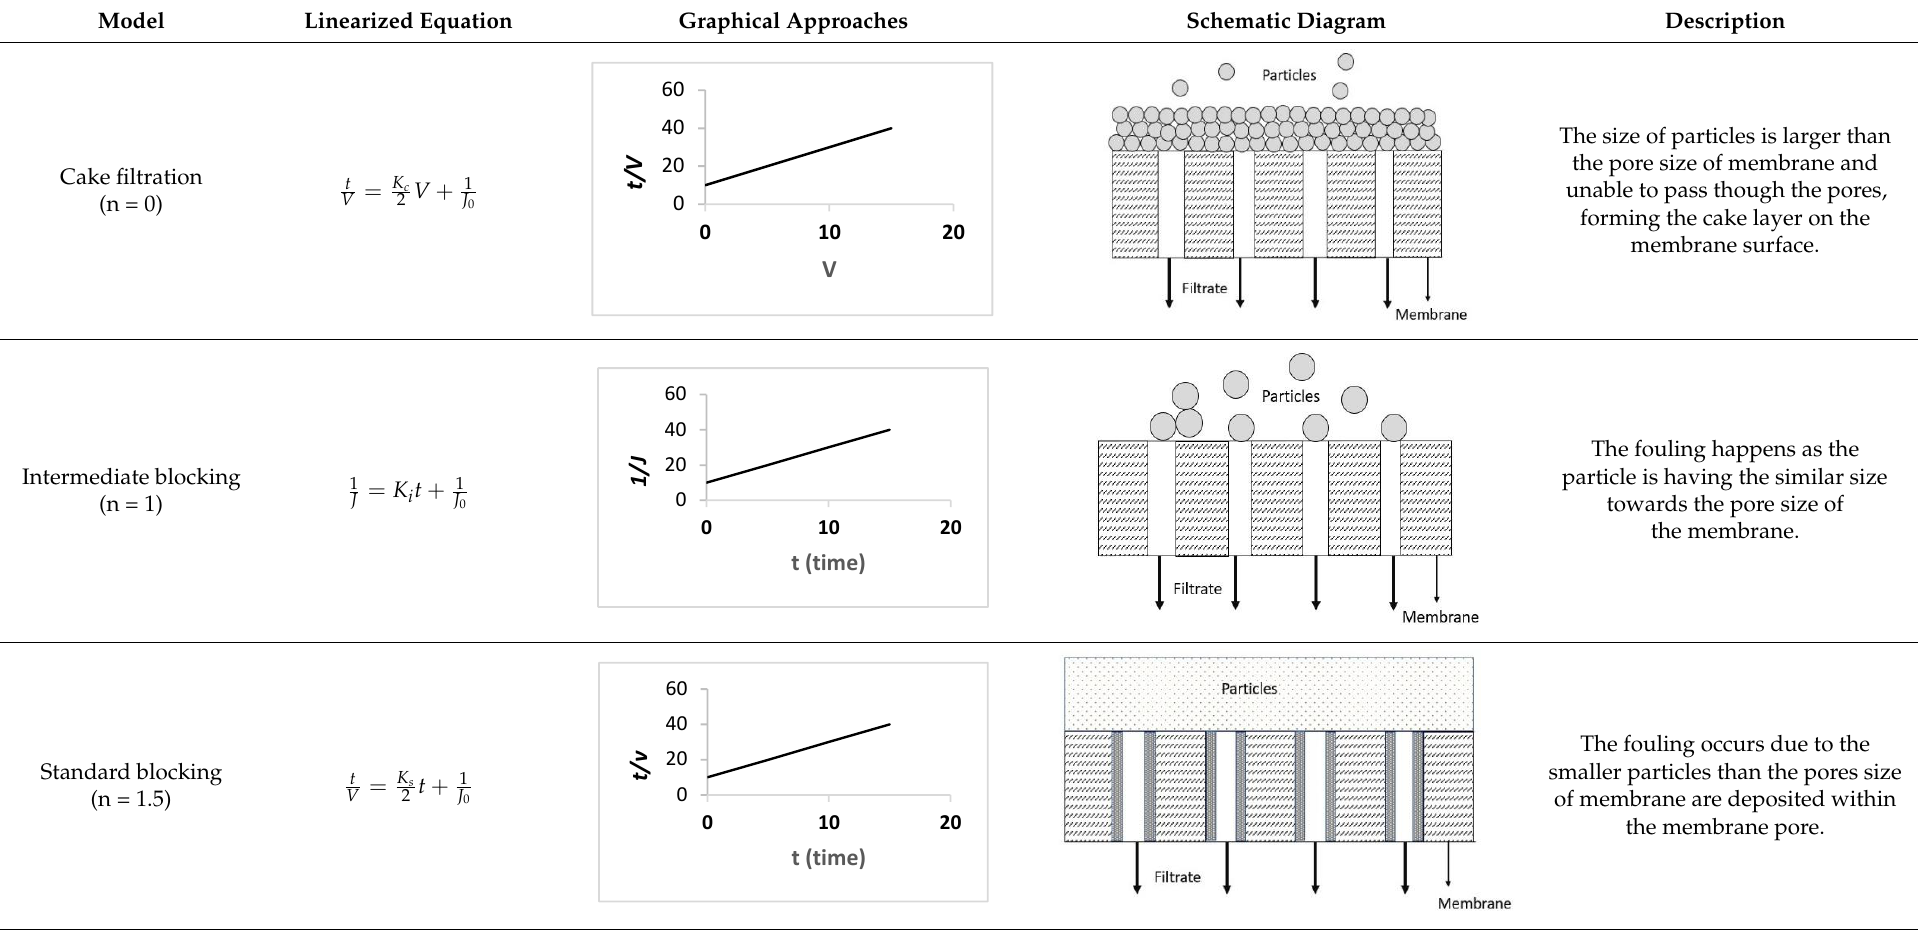
Table 3. Hermia’s models for constant pressure filtration [26,27] .